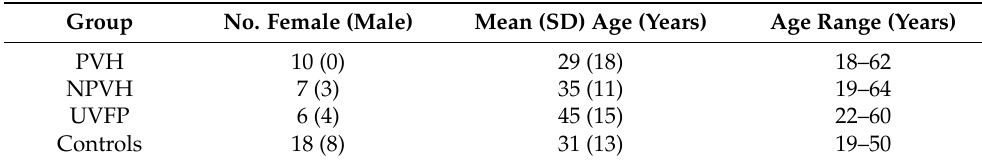
Table 1. Demographics of the study participants in the three patient groups and the vocally typical control group.